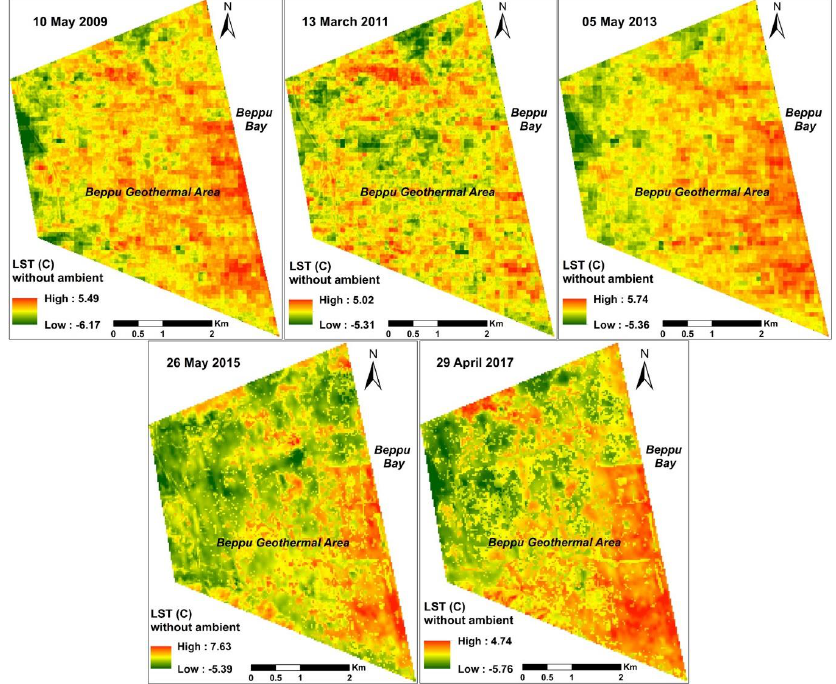
Figure 14. Land surface temperature without ambient temperature of the Beppu geothermal area, derived from nighttime ASTER infrared data using split-window algorithm for 2009, 2011, and 2013 (top row), and derived from nighttime Landsat 8 TIRS data using split-window algorithm for 2015 and 2017 (bottom row).